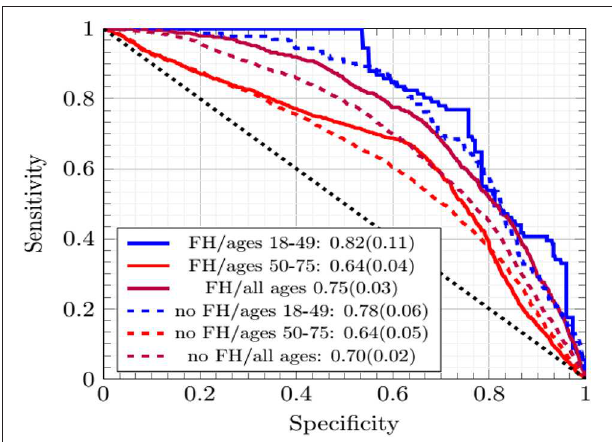
FIGURE 2 | The ROC curves of the ANNs averaged across cross-testing for different sub-demographics and with/without family history